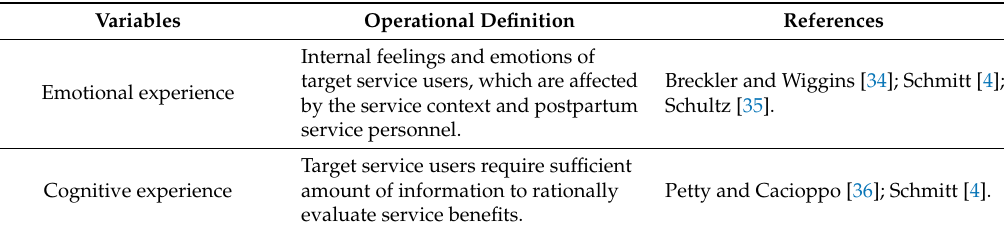
Table 1. Operational definitions of service experience variables.